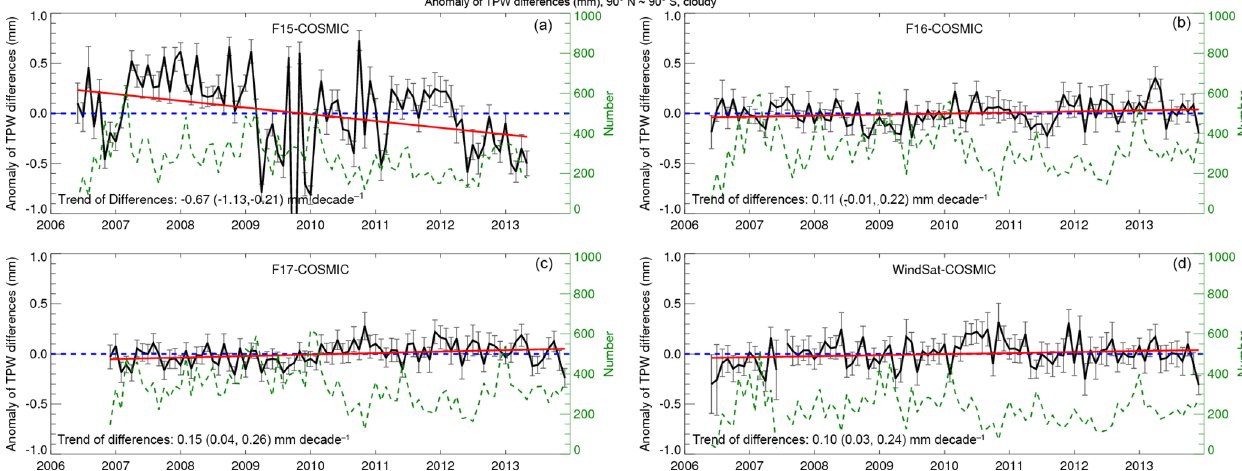
Figure 8. The time series of deseasonalized TPW differences (microwave radiometer – COSMIC) under cloudy skies for (a) F15, (b) F16, (c) F17, and (d) WindSat. The black line is the mean difference for microwave radiometer minus COSMIC; the vertical lines superimposed on the mean values are the standard error of the mean. The number of the monthly MW radiometer–COSMIC pairs is indicated by the green dashed line (scale on the right y axis). The trends are shown by a solid red line. The 95% confidence intervals for slopes are shown in the